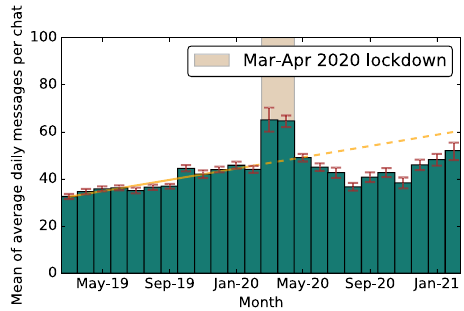
Fig. 6 Average number of the mean of daily messages per chat per month. In this Figure, each bar shows the mean number of daily messages per chat per month with their corresponding 95% con fi dence intervals on top (red). The trend of the pre-pandemic period (linear regression of the means from March 2019 to February 2020) is marked as dashed yellow line, while the lockdown period (March to April 2020) is highlighted in